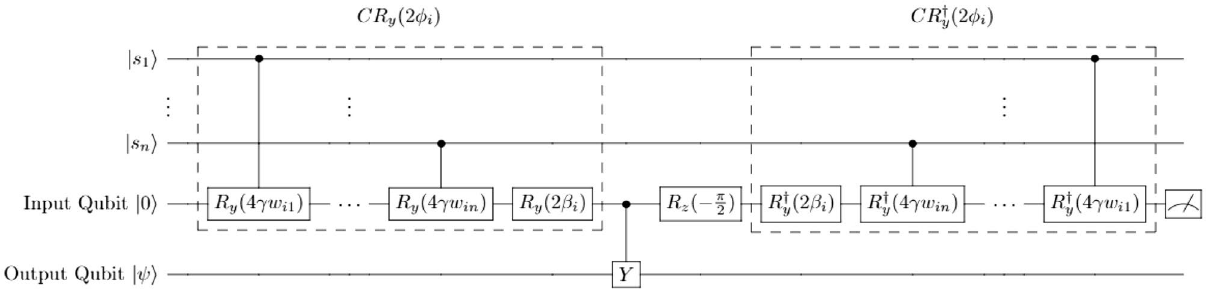
Figure 1. Quantum neuron circuit architecture based on Cao et al. 6 . The basic quantum neuron architecture designed by Cao et al. 6 utilizes controlled rotations dependent on a superposition of input states to create a 0 controlled rotation CR y ( 2 φ) . A measurement of on the input qubit indicates that the output qubit has been | � 1 arctan ( tan 2 φ) . If rotated R y ( 2 q (φ)) with q (φ) is measured, the circuit has applied R y ( π 2 ) to the output = | � qubit, in which case this rotation is reversed and the circuit is repeated until success is